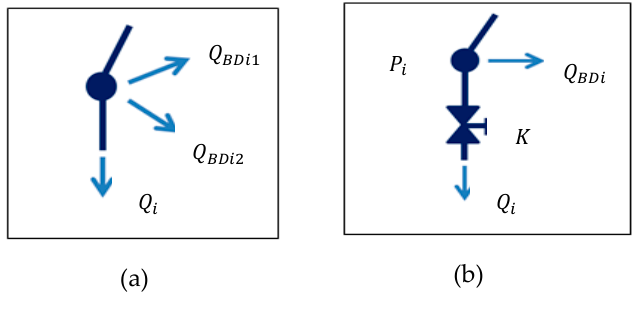
Figure 1. Modeling a water leak in EPANET: ( a ) case of additional demand; ( b ) case of flow through a